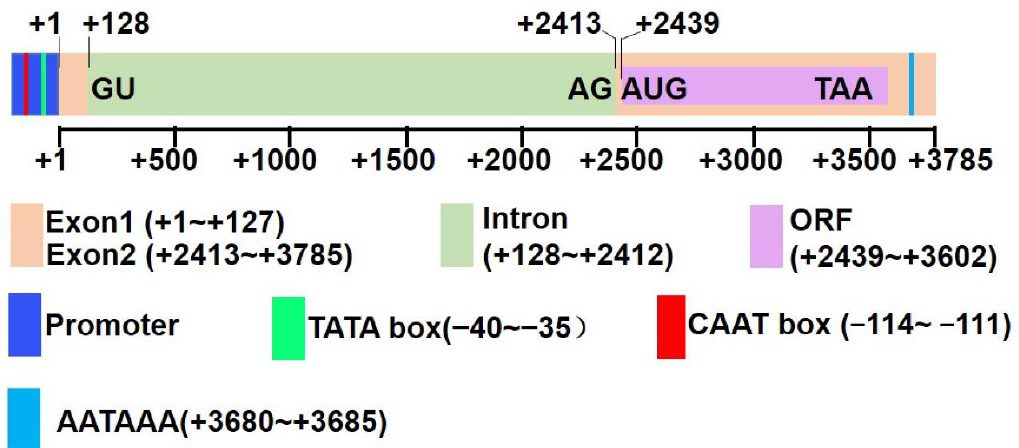
Figure 1. The structure of RcFAH12 . The primary transcript form of RcFAH12 consists of two exons and one intron with a 2438 bp 5 ′ untranslated region (5 ′ UTR), 183 bp 3 ′ untranslated region (3 ′ UTR), and 1164 bp ORF. The exons are 127 and 1373 bp, separated by one intron of 2285 bp. The sequence at the 5 (cid:48) end of the intron is GU and the sequence at the 3 (cid:48) end is AG. The polyadenylation signal (AATAAA) in the RcFAH12 cDNA was present at 101 bp before the poly-A